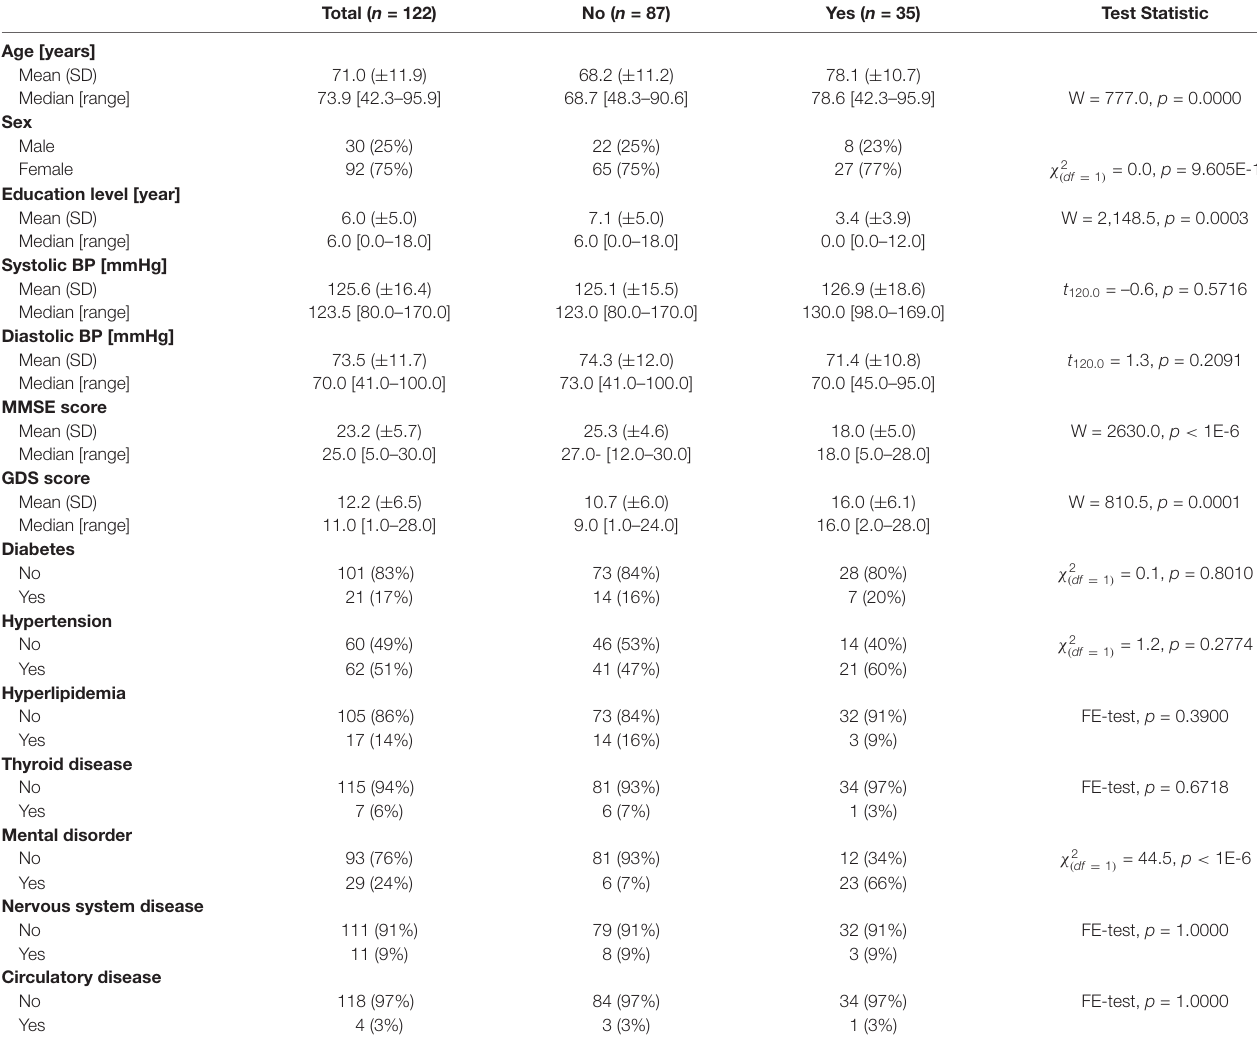
TABLE 2 | Demographic information and neuropsychological test results of dementia and non-dementia